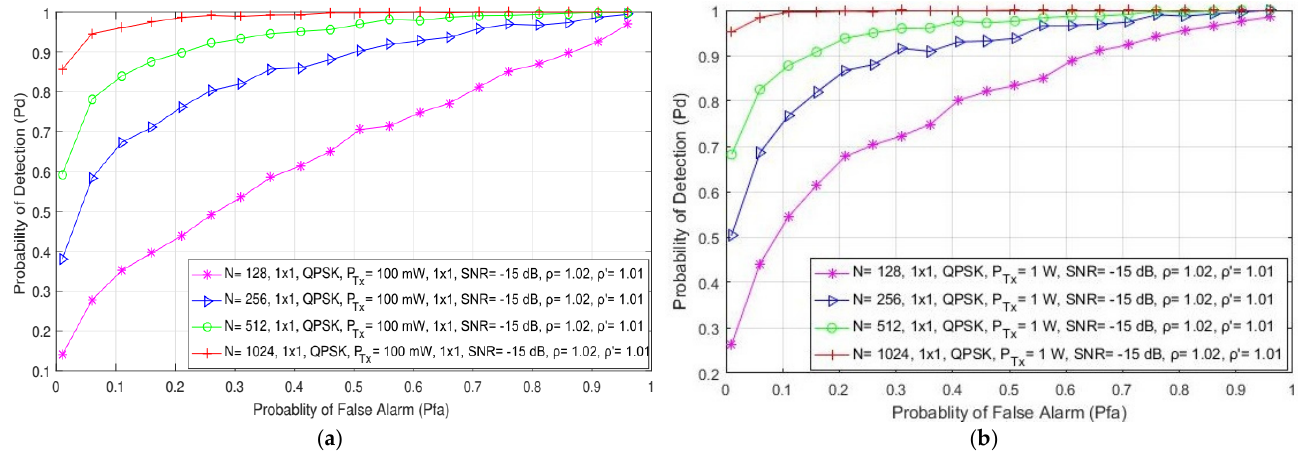
Figure 4. The ROC curves presenting the ED performance for the different PU Tx powers and the SNR of − 20 dB in ( a ) SISO, ( b ) 2 × 2, ( c ) 2 × 4 and ( d ) 2 × 6 MIMO communication systems.